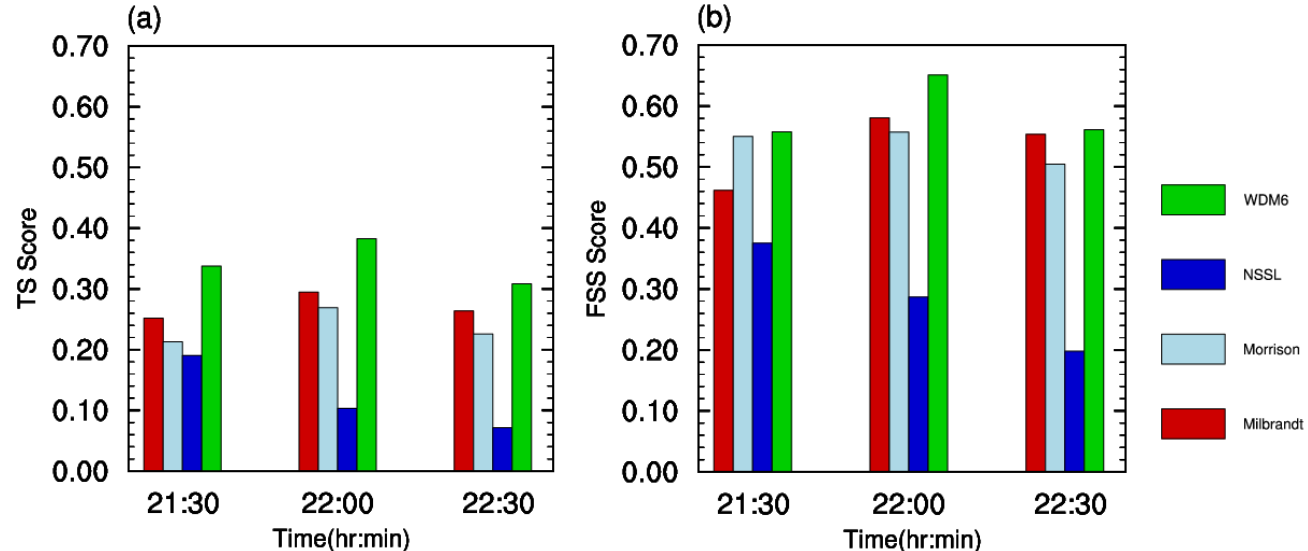
Figure 11. ( a ) Threat scores and ( b ) Fractions Skill scores of predicted reflectivity for the 40 dBz threshold value with four double-moment MP schemes from 2130 UTC to 2230 UTC 15 April 2016.